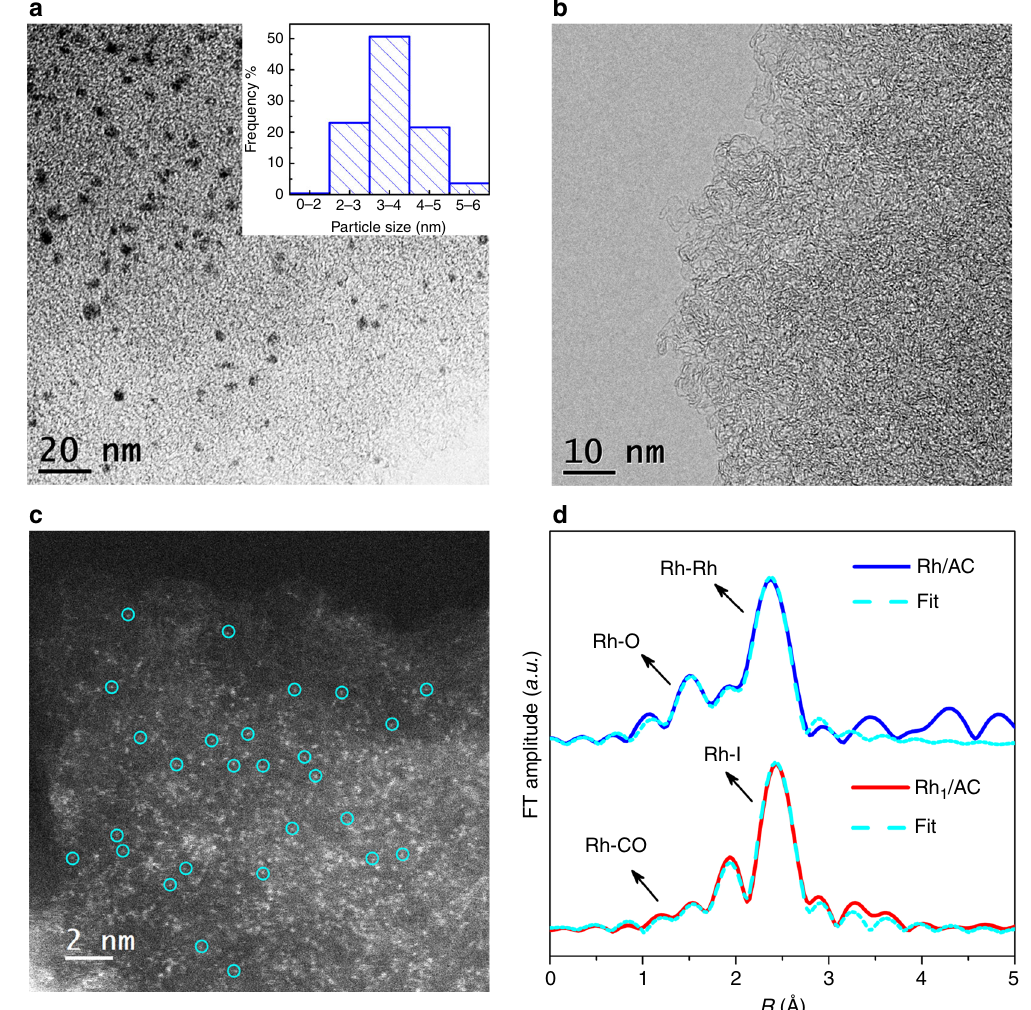
Fig. 1 Structure of the Rh/AC and Rh 1 /AC catalysts. a The HRTEM image of Rh/AC and the corresponding particle size distribution. b The HRTEM and c HAADF-STEM image of Rh 1 /AC. d Comparison of the experimental (solid line) and fi tted (dashed line) curves of k 2 -weight EXAFS spectra of Rh/AC and Rh 1 /AC